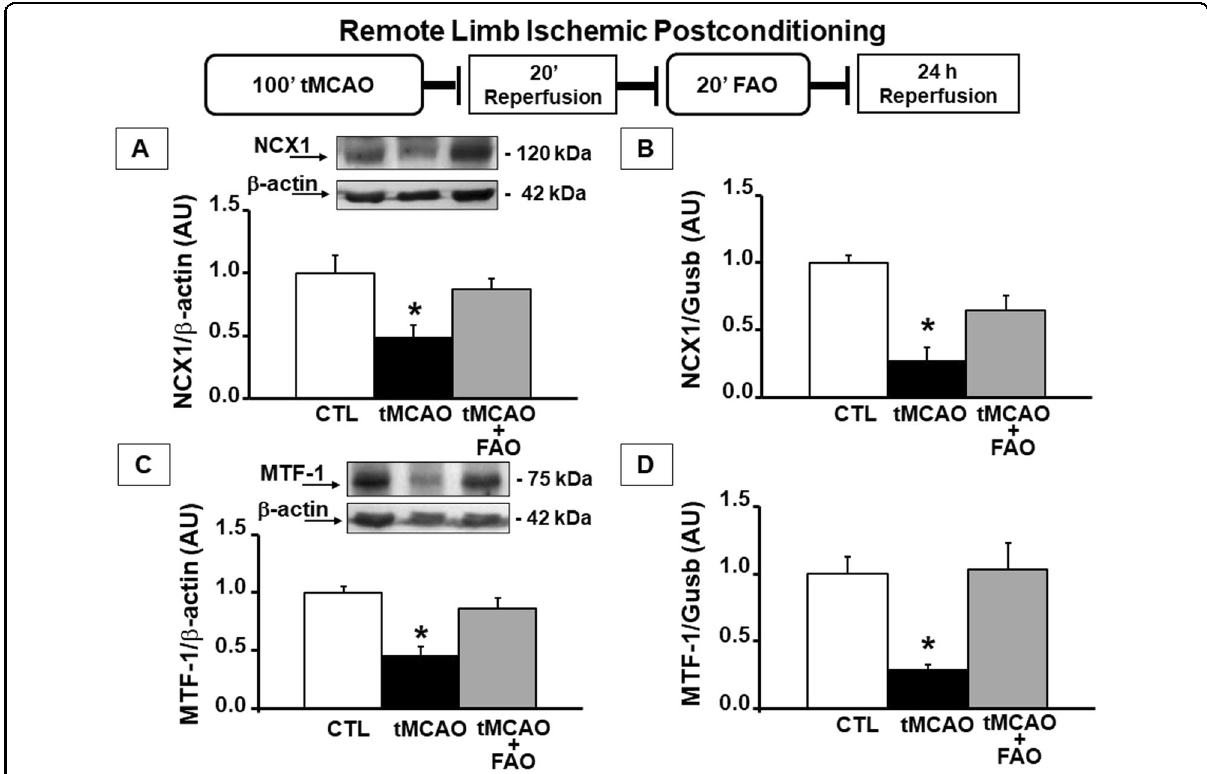
Fig. 4 Remote limb ischemic postconditioning was able to revert the downregulation of NCX1 and MTF-1 induced by the ischemic insult. A Diagram showing the experimental model of remote limb ischemic postconditioning (RLIP) used. In particular, a 20 ’ occlusion of the femoral artery (FAO) followed a 100 ’ of transient middle cerebral artery occlusion (tMCAO), spaced by 20 ’ of reperfusion. A – C Real-time PCR for the evaluation of Ncx1 ( A ) and Mtf-1 ( C ) expression levels in the cortex of rat: (i) sham-operated (CTL); (ii) exposed to tMCAO (tMCAO); and (iii) tMCAO + FAO. B – D Representative Western blot of NCX1 ( B ) and MTF-1 ( D ) proteins in the cortex of rat: (i) sham-operated (CTL); (ii) exposed to tMCAO (tMCAO); and (iii) exposed to tMCAO + FAO (tMCAO + FAO). * p < 0.05 vs. CTL by one-way ANOVA followed by Bonferroni test. Each column represents the mean ± SEM ( n =